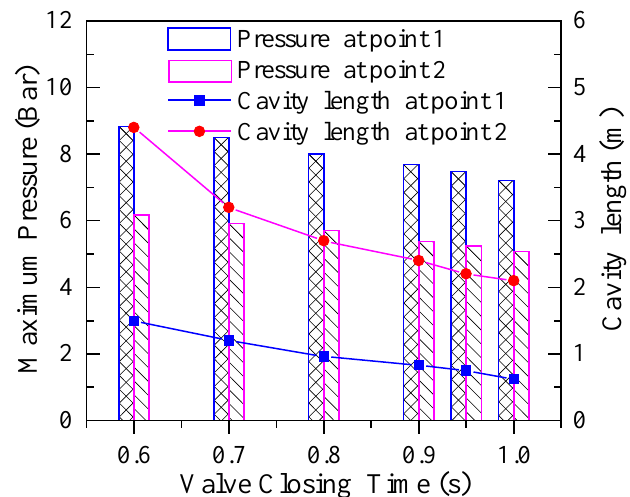
Figure 11. Relationship among the valve closing time, measured maximum pressure, and cavity length.